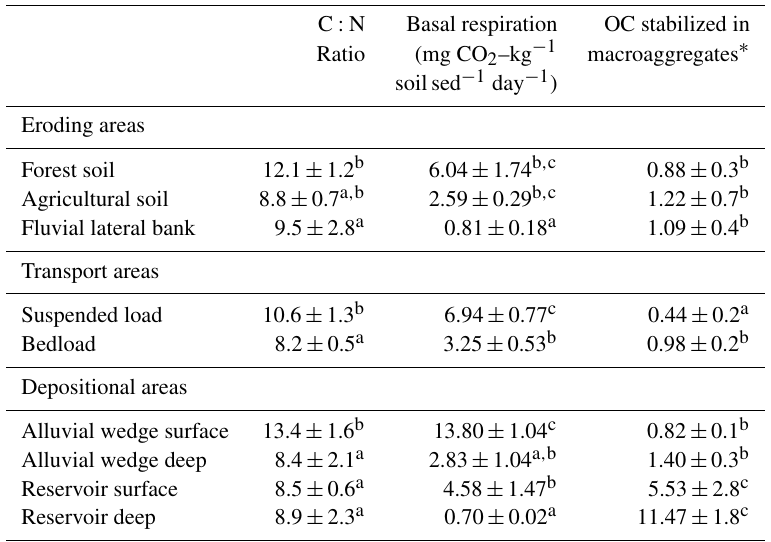
Numeral values are means ± SE. Columns with different lowercase letters indicate significant differences among sites or processes ( p< 0 . 05 ) according to the Kruskal–Wallis test. Rows with different capital letters mean significant differences between OC fractions within each site or process. Table 4. C : N ratios, basal respiration rate, and indicators of OC stabilized in macroaggregates (OC-Mm + OC-Mmin / OC- M pom ) in the different morphological positions across the catchment: eroding, transport, and depositional areas.